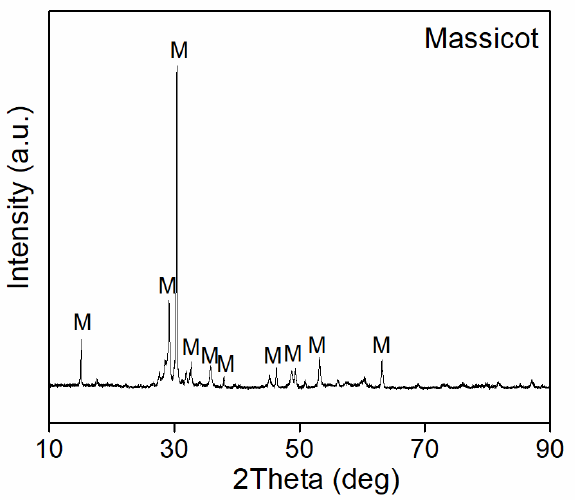
Figure A10. XRD result for burned lead. Massicot (M) was identified.